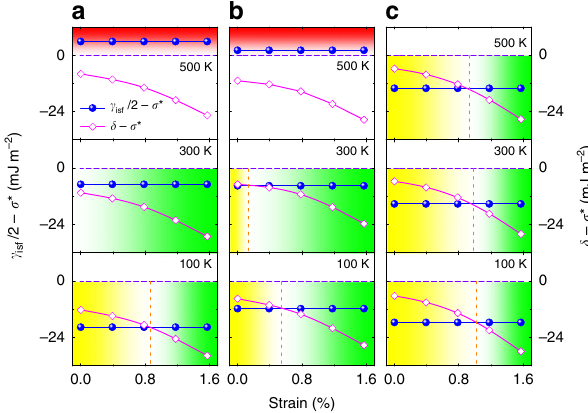
Fig. 4 Twinning parameters as a function of the af fi ne shear strain. = 2 (cid:2) σ (cid:7) ) and ( δ (cid:2) σ (cid:7) ) for three a – c show the strain-dependence of ( γ isf different temperatures for the Fe 40 Mn 40 Co 10 Cr 10 , CrMnFeCoNi, and CrCoNi alloys, respectively. Metastable twinning corresponds to ð γ , unstable stacking fault (cid:1) (cid:3) usf = 2 (cid:2) σ (cid:7) Þ < 0 (green area), martensitic σ (cid:7) Þ > ð δ (cid:2) σ (cid:7) Þ and ð γ as a (cid:2) (cid:1) γ isf SF TW